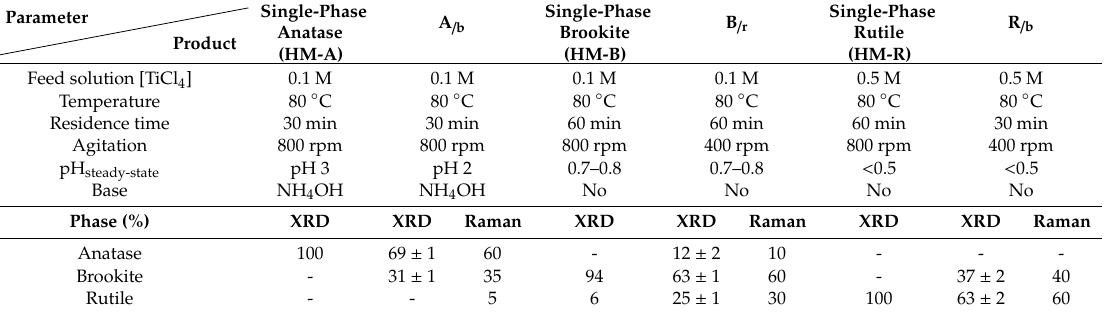
Table 1. Mixed-phase nanoTiO 2 produced under di ff erent conditions; comparison with the standard single-phase anatase, brookite, and rutile